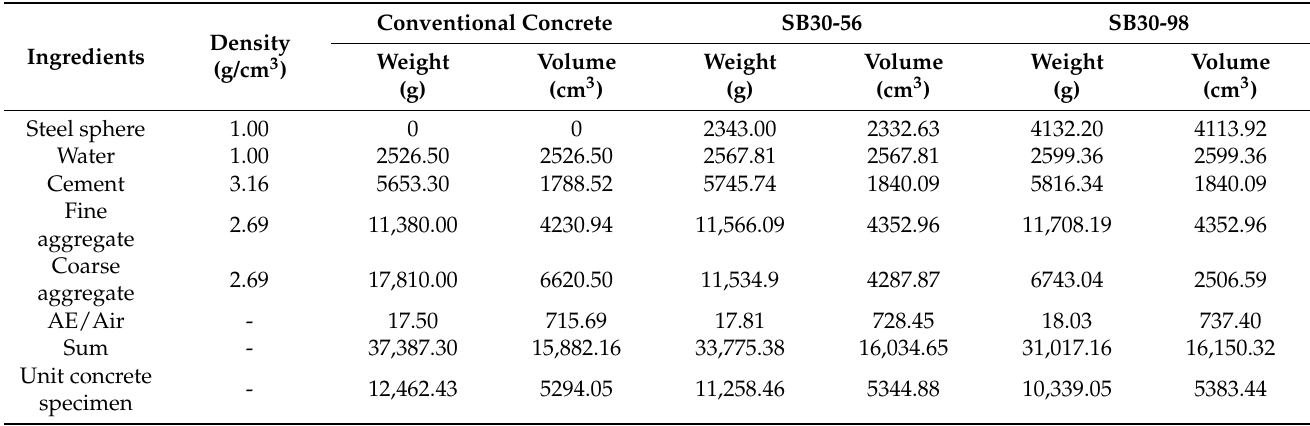
Table 2. Concrete mix ratio and the amount of steel spheres mixed.